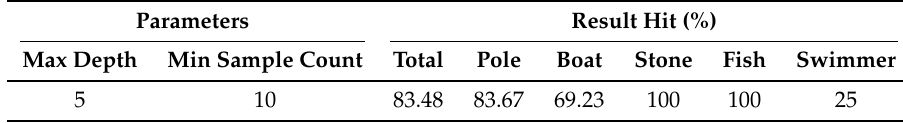
Table 8. Unbalanced 10D Feature results—Random Trees.